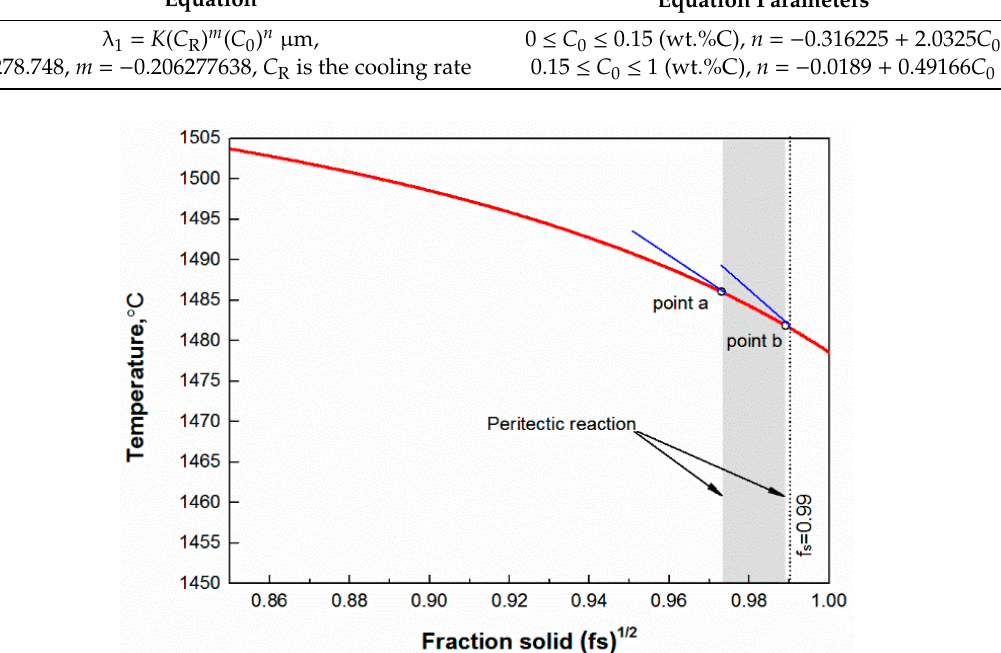
Figure 2. An example of a calculated T − (f s ) 1/2 curve.